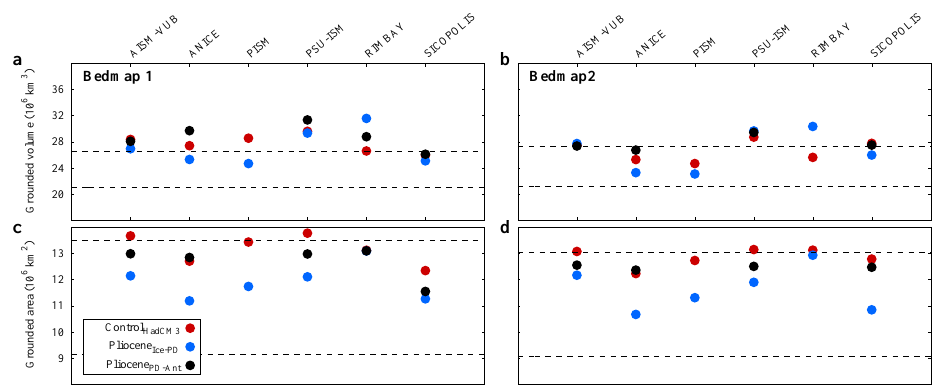
Figure 12. Final grounded ice volume (10 6 km 3 ) and grounded ice area (10 6 km 2 ) for the six models. (a) Grounded ice volume with Bedmap1. (b) Grounded ice volume with Bedmap2. (c) Grounded ice area with Bedmap1, and (d) Grounded ice area with Bedmap2. Control HadCm3 in red, Pliocene Ice-PD in blue and Pliocene PD-Ant in black. The horizontal dashed lines indicate the PD and Pliocene grounded ice volume and ice area of the initial ice-sheet topographies with Bedmap1 (a, c) and Bedmap2 (b, d)